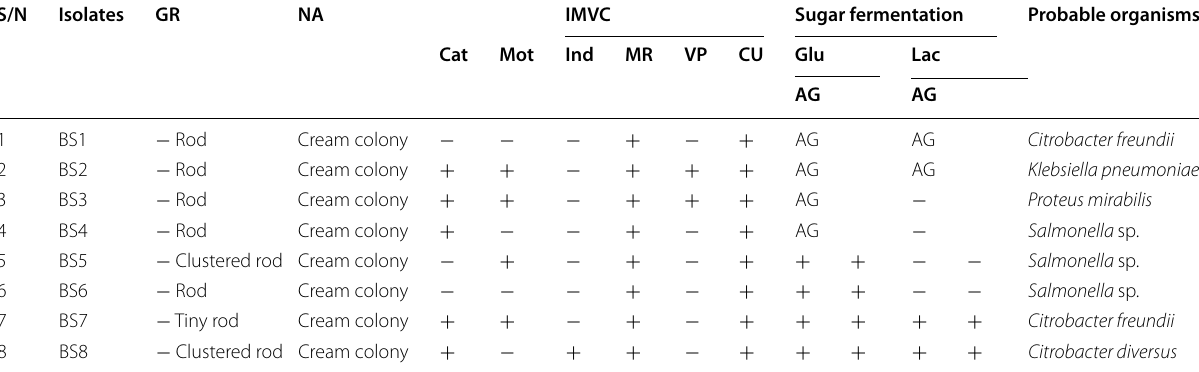
GR Gram reaction, NA Nutrient agar, Cat Catalase, Mot Motility, Ind Indole, MR Methyl red, VP Voges–Proskauer, CU Citrate utilization, Glu Glucose, Lac Lactose, A Acid production, G Gas production, BS Bacteria soil (sample)